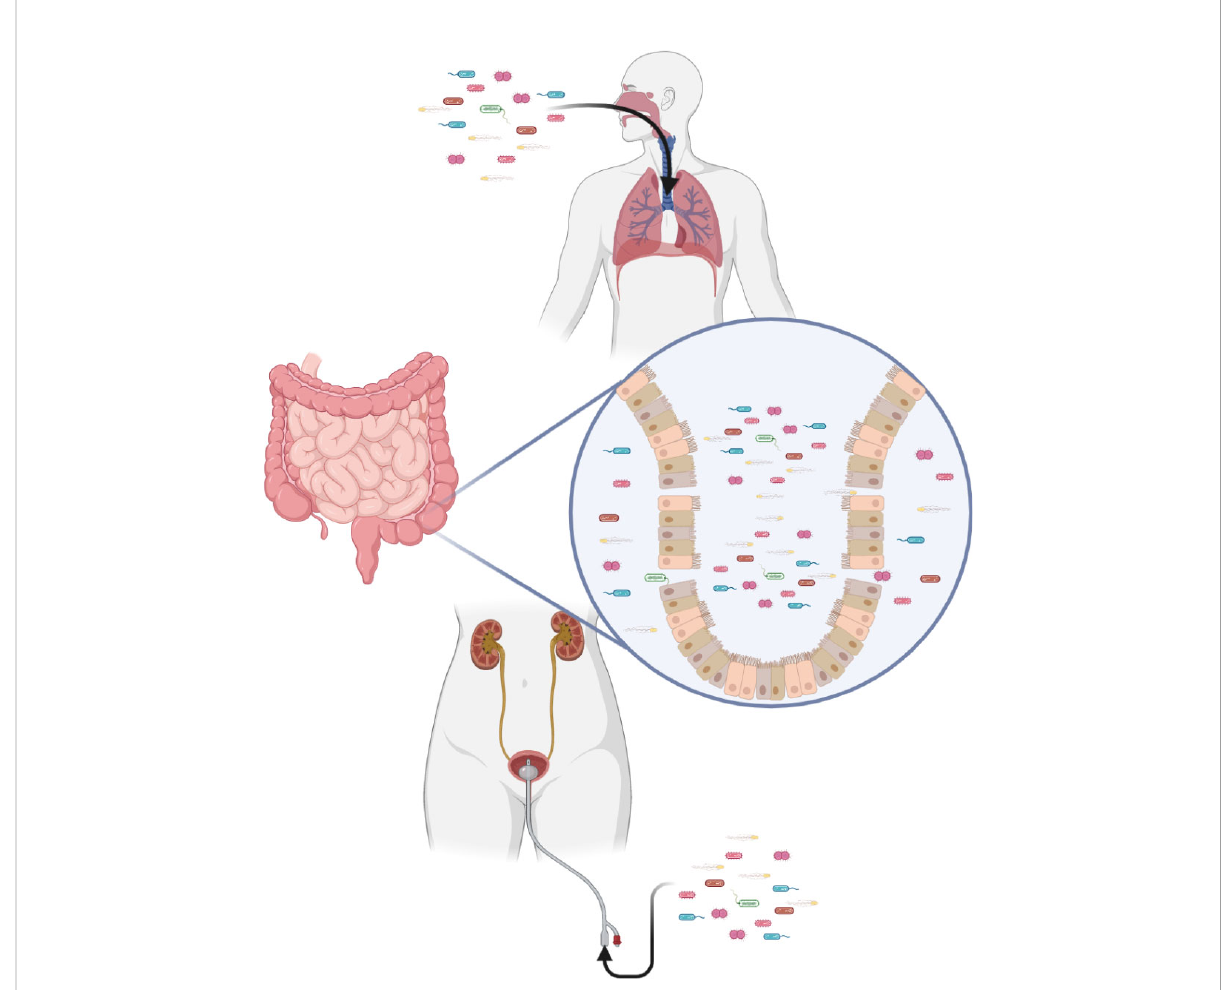
FIGURE 3 Immunosuppression after stroke increases the risk of infection. Exogenous pathogens can infect the lungs and urinary tract. Translocation of intestinal fl ora is also a potential